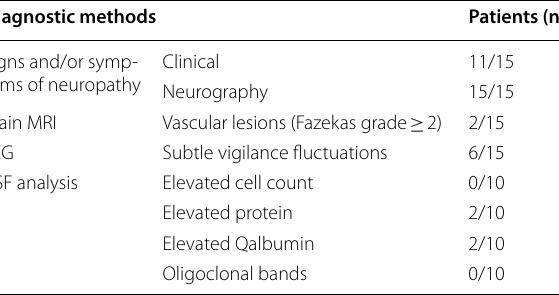
Table.1 Baseline characteristics: CSF examination (n other diagnostic findings